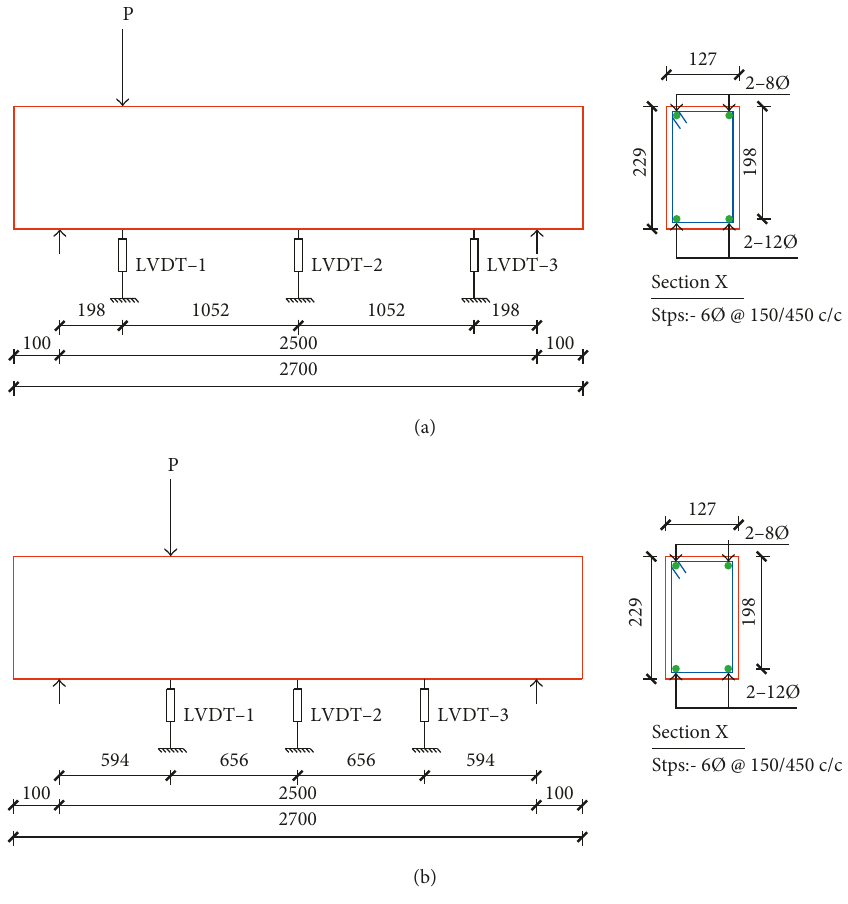
Figure 2: Schematic diagram of the test setup: (a) beams tested at a / d � 1; (b) beams tested at a / d � 3. Table 5: Test results of controlled DB and